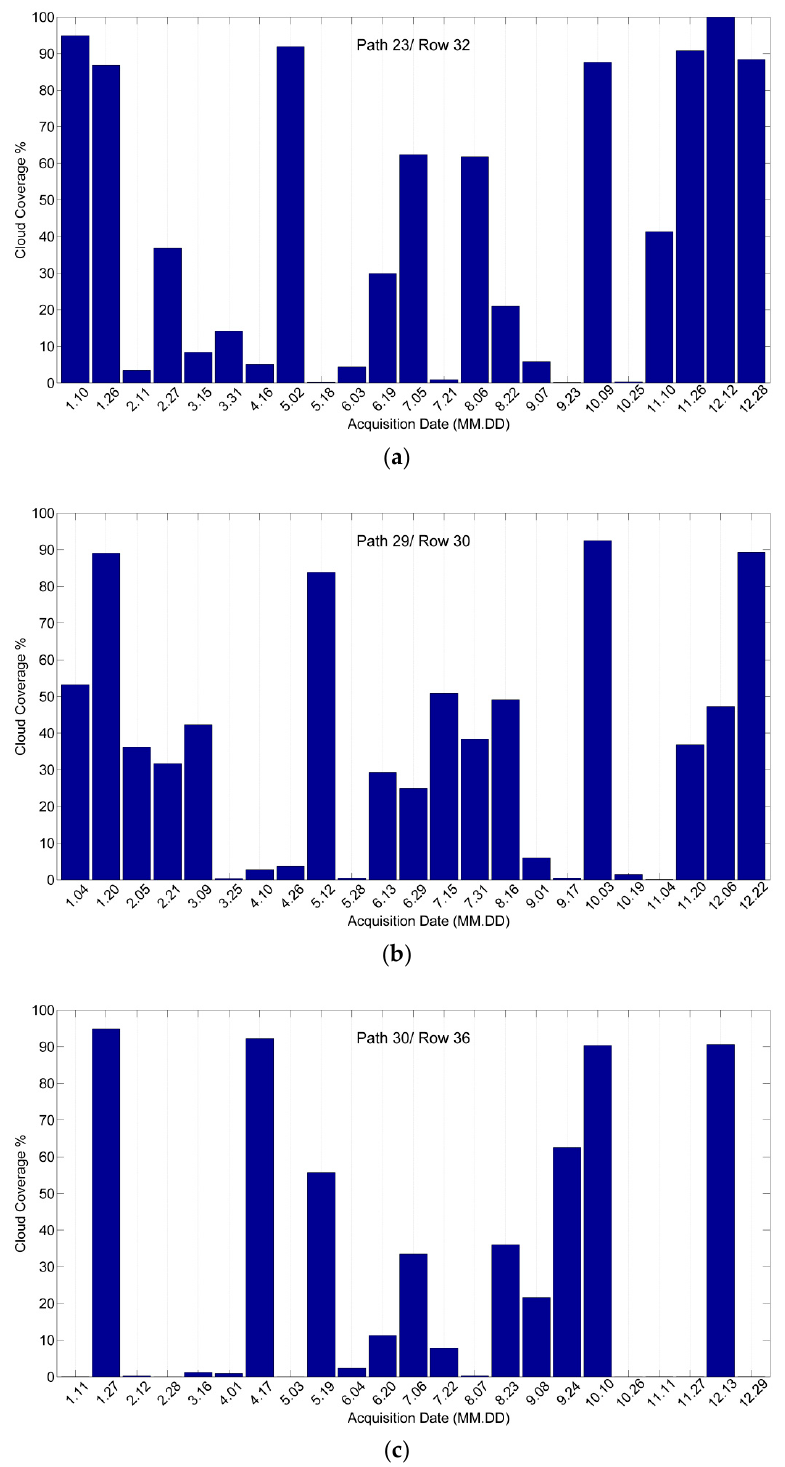
Figure 1. The acquisition date and cloud coverage of each study area. ( a ) Illinois study area. ( b ) South Dakota study area. ( c ) Texas study area.